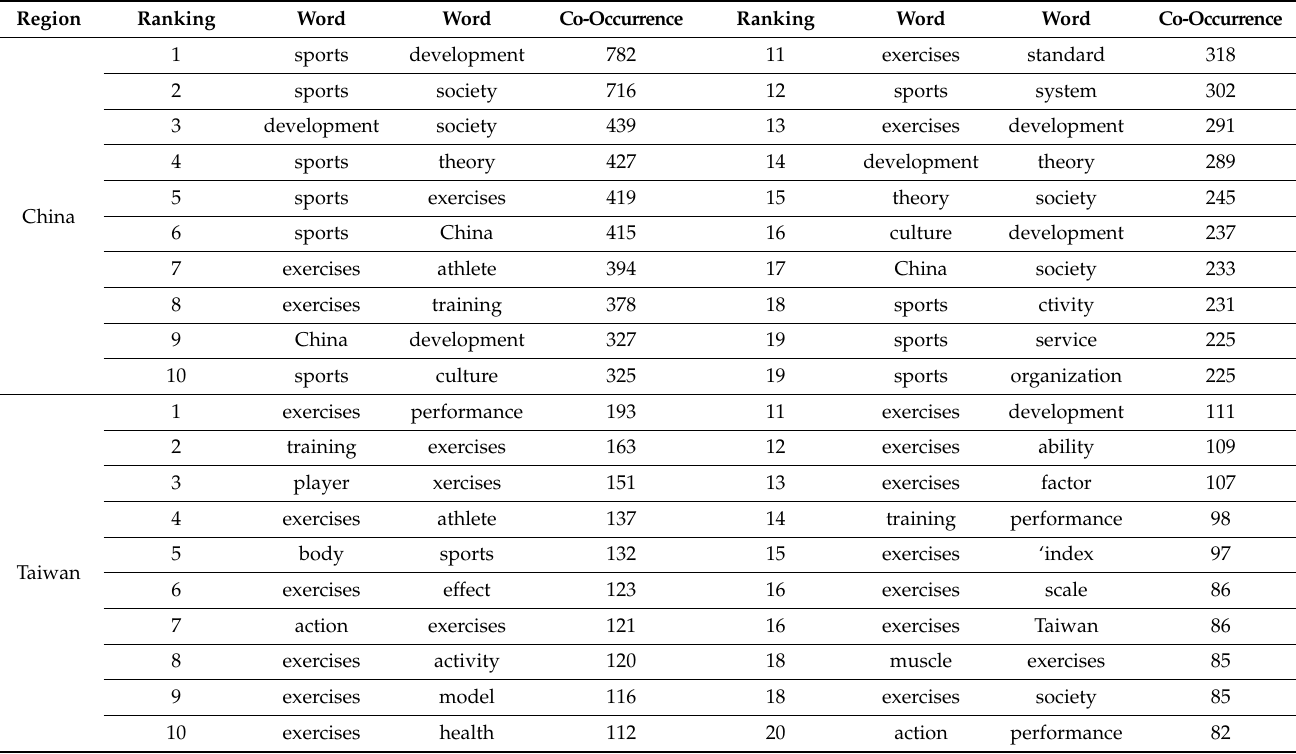
Table 3. Statistics of co-occurrence times.